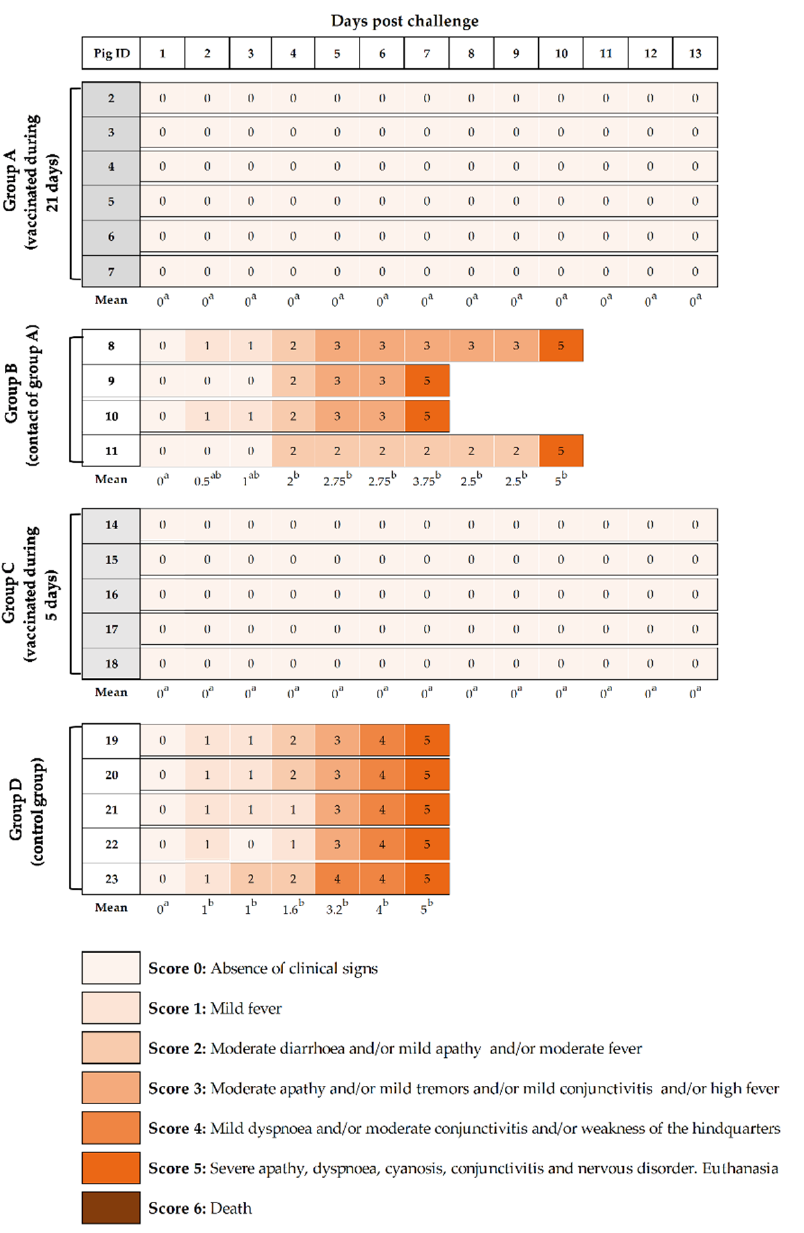
Figure 2. Clinical signs monitored after challenge. The individual clinical signs were recorded after CSFV “Margarita” strain infection. Animals 2 to 7 (group A) and 14 to 18 (group C) were challenged after 21 and 5 dpv, respectively. Animals 8 to 11 (group B), contacts for group A and 19 to 23 (group D), infection control group, were not vaccinated but challenged. Pigs were monitored daily for clinical signs during the 13 dpc or until euthanasia. Different shades of colour and the numerical clinical score represent the severity of the clinical signs as shown in the legend. Super-indexed letters in the mean clinical score value from each group are employed to represent statistically significant differences between the groups on that day; similar letters indicate no statistical difference, and different letters show statistical difference ( p <